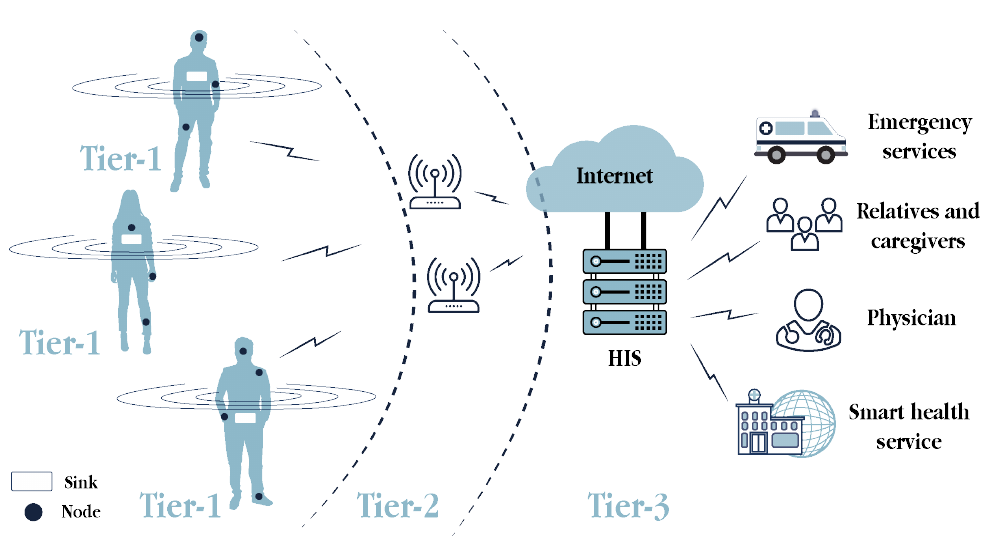
Figure 3. Component-based representation of the 3-tier communication architecture for